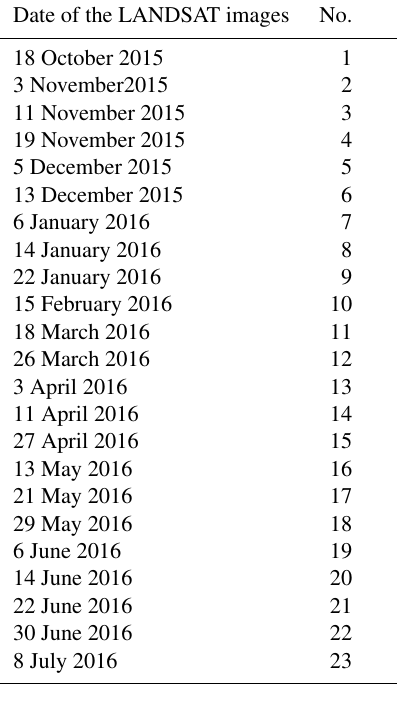
Table 2. Date of the LANDSAT images used in the present study (path 001, row 071; images from the website: https://landsatlook. usgs.gov/viewer.html, last access: 15 March 2018).